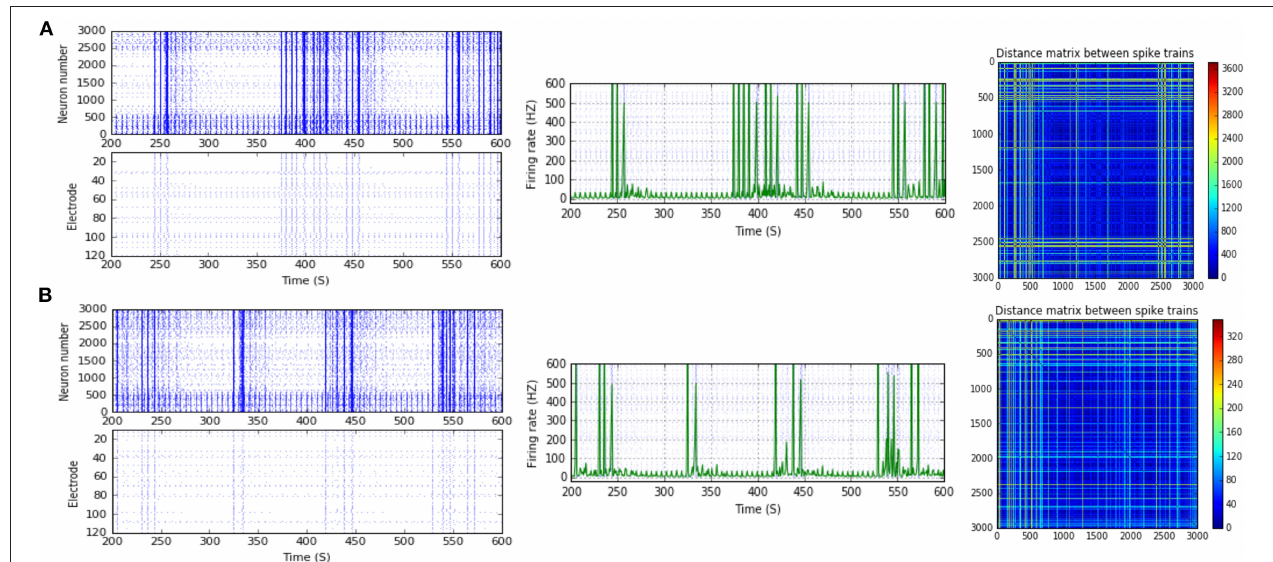
FIGURE 7 | Selected elicited firing response activity in the immature network scenario (B-2) before and after implementing STF1 (when IF beta). (A) refers to the condition without implementing dynamical synapses (control) while (B) refers to that after implementing facilitating synapses (STF1). The first two figures of each panel refer to monitoring the pattern of firing activity in time windows from 200 to 600 seconds(s). Heat maps of each panel represent the modulation changes in spike distance matrix of the network scenario (B-2) before and after implementing STF1. The simulation time for heat maps of the spike distance is equal to